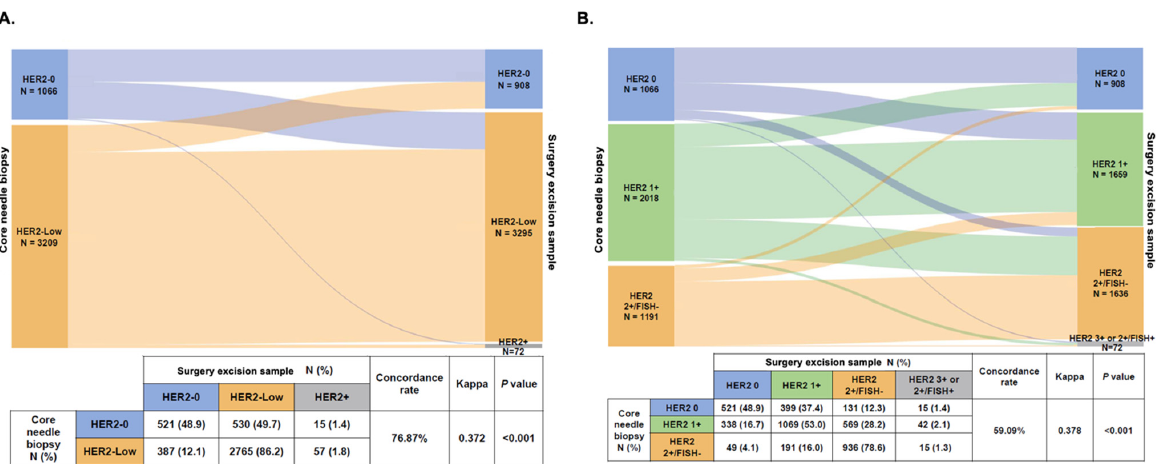
Figure 3. HER2 status change ( A ) and HER2 expression evolution ( B ) from core needle biopsy sample to surgical excision sample in HER2-Negative patients. Abbreviations: HER2, human epidermal growth factor receptor-2; FISH, fluorescence in situ hybridization.